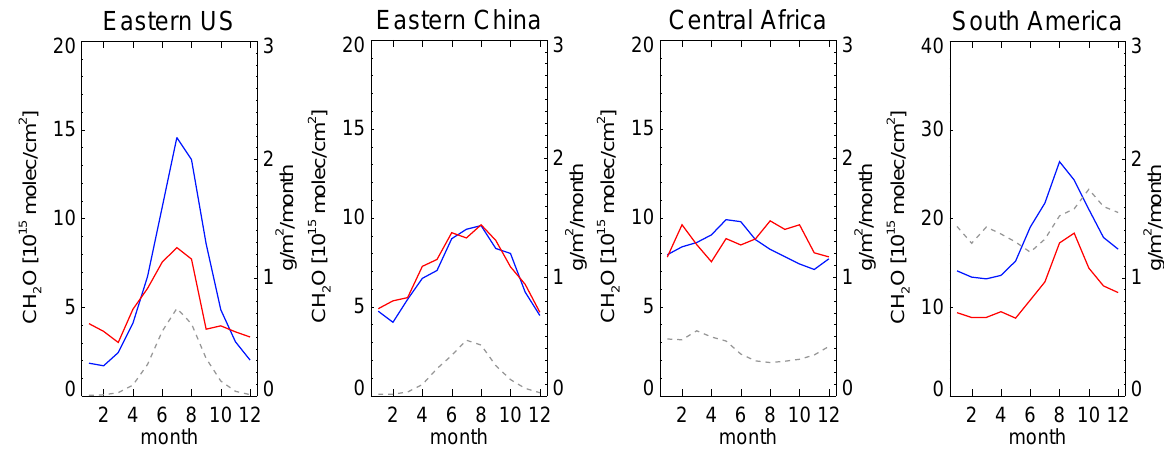
Fig. 8. The annual cycle in the observed (SCIAMACHY, red) and modeled (blue) CH 2 O tropospheric columns at 10:30 h LT over four selected regions. Dashed lines in grey indicate the isoprene emission flux in g/m 2 /month. Note the different scale for the columns over South